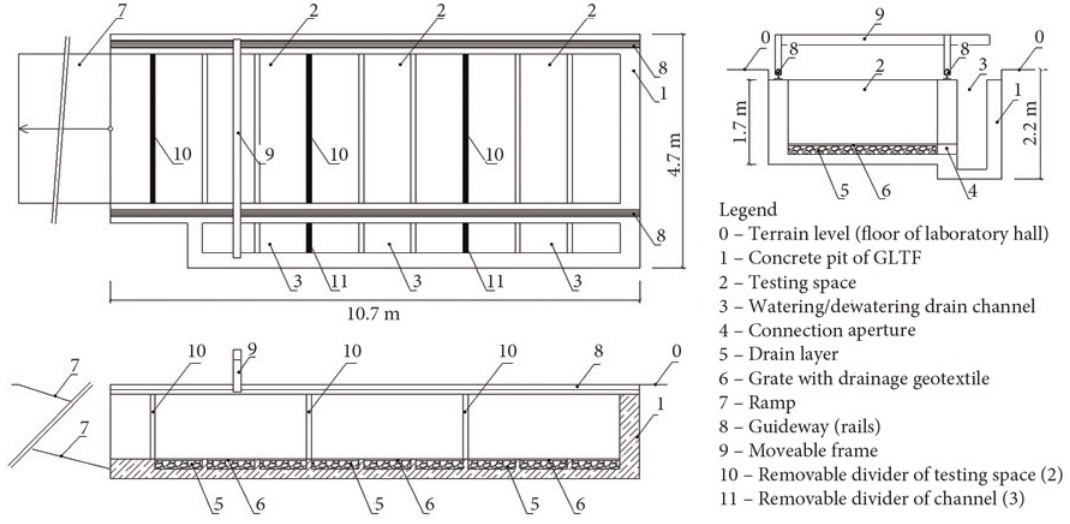
fig. 6. GLTF built in laboratories of CDV (Pospisil